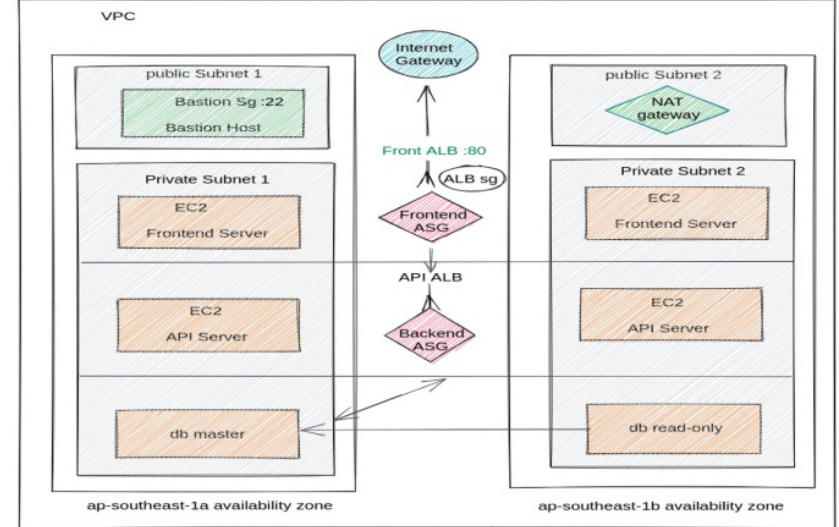
Fig. 5 SSH three-tier architecture